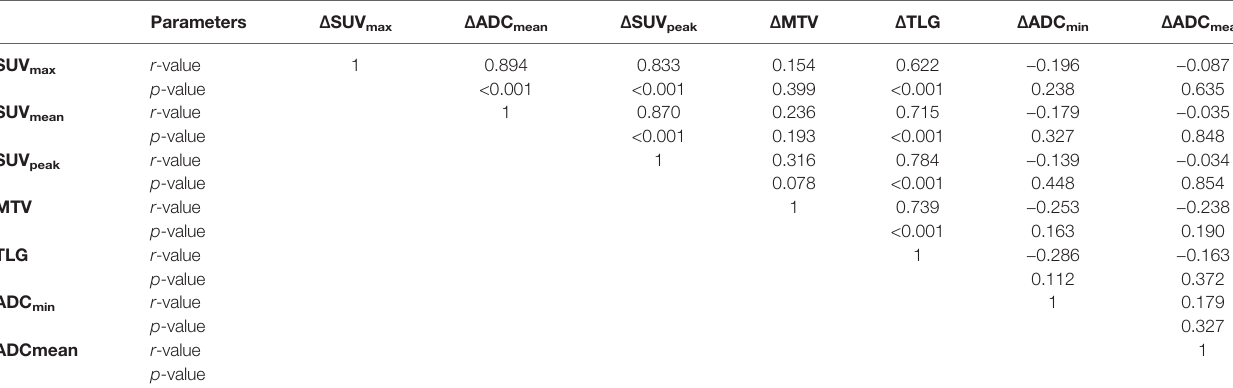
TABLE 3 | Correlation analysis of relative changes in SUV and ADC values before and during radiotherapy. Parameters